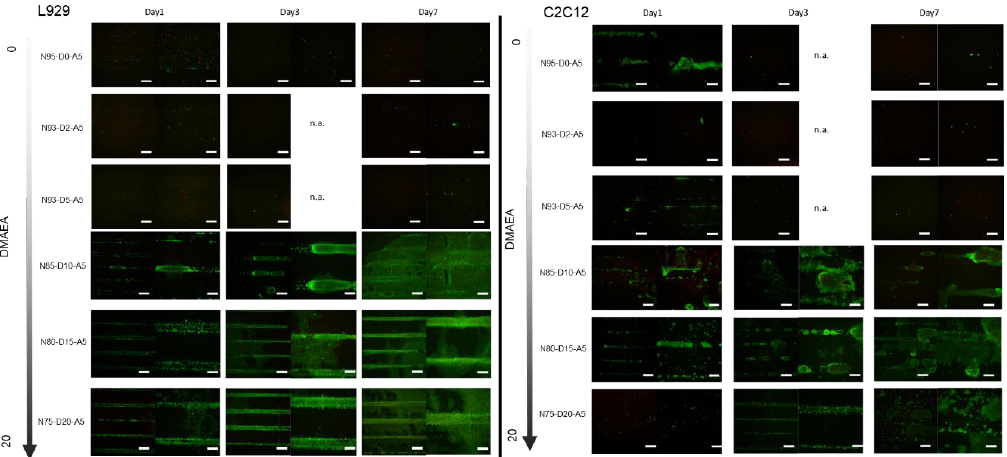
live cells on two formulations, N85-D10-A5 and N80-D15-A5 (3% TMPTA, 10 s/layer), at day 1, 3, and 7. Scale bars equal 500 µm (low magnification (4×), left images) or 200 µm (higher magnification (10×), right images). P-value is denoted as *p.